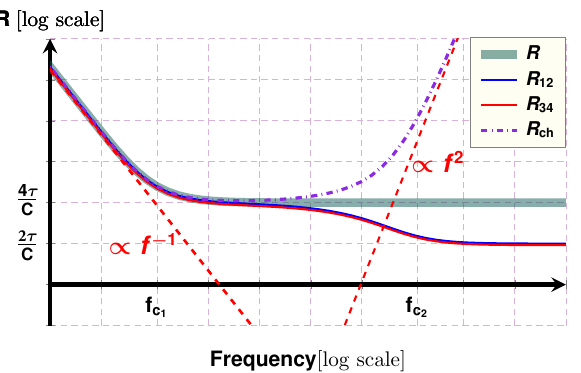
Figure 13. RN-G model characteristics summary for the case when τ avg = 2 R on C , showing the behavior of various resistors, including R as a reference.